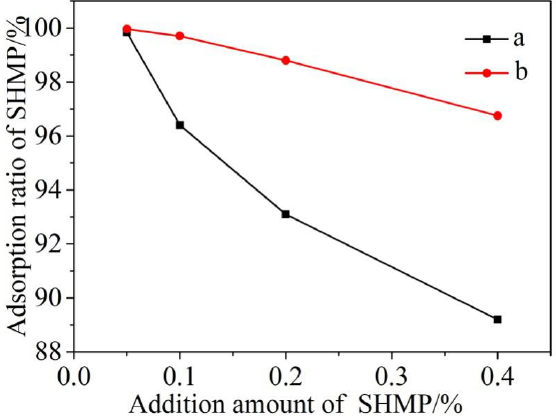
Figure 2. Adsorption ratio of SHMP after 5 min (a) and 30 min (b) stirring, respectively, as a function of the addition amount of SHMP.